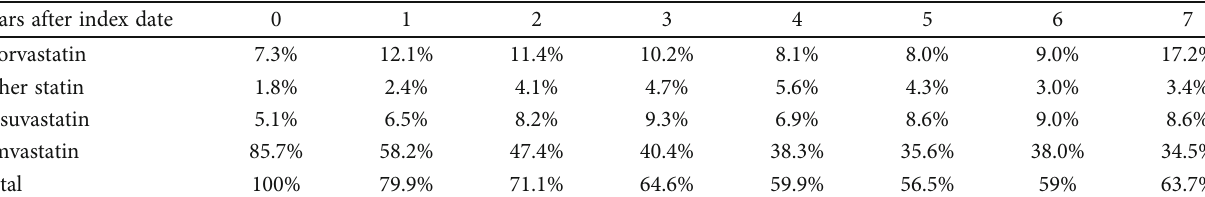
Table 3: Percentage statin users per year after index